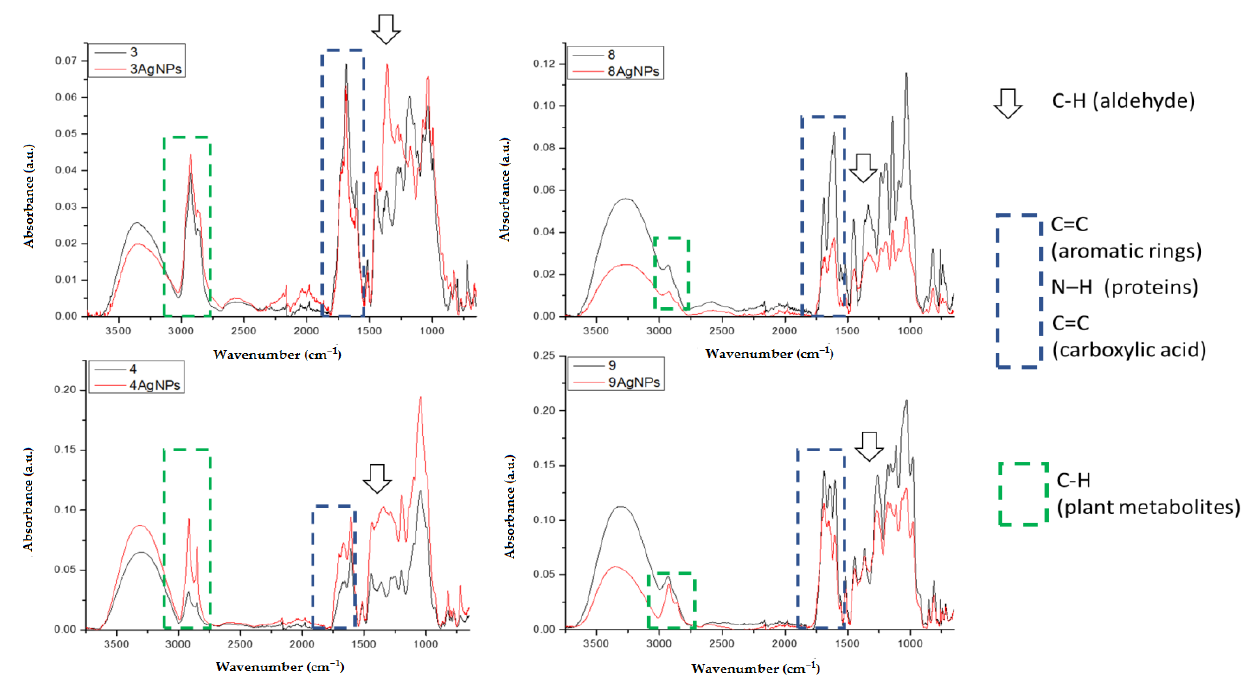
Figure 5. FTIR spectra in the range 4000–650 cm − 1 of freeze-dried extracts and AgNPs synthesized in presence of extracts from: 3- Salvia officinalis , 4- Tilia cordata, 8- Camellia sinensis, and 9- Ilex paraguariensis.